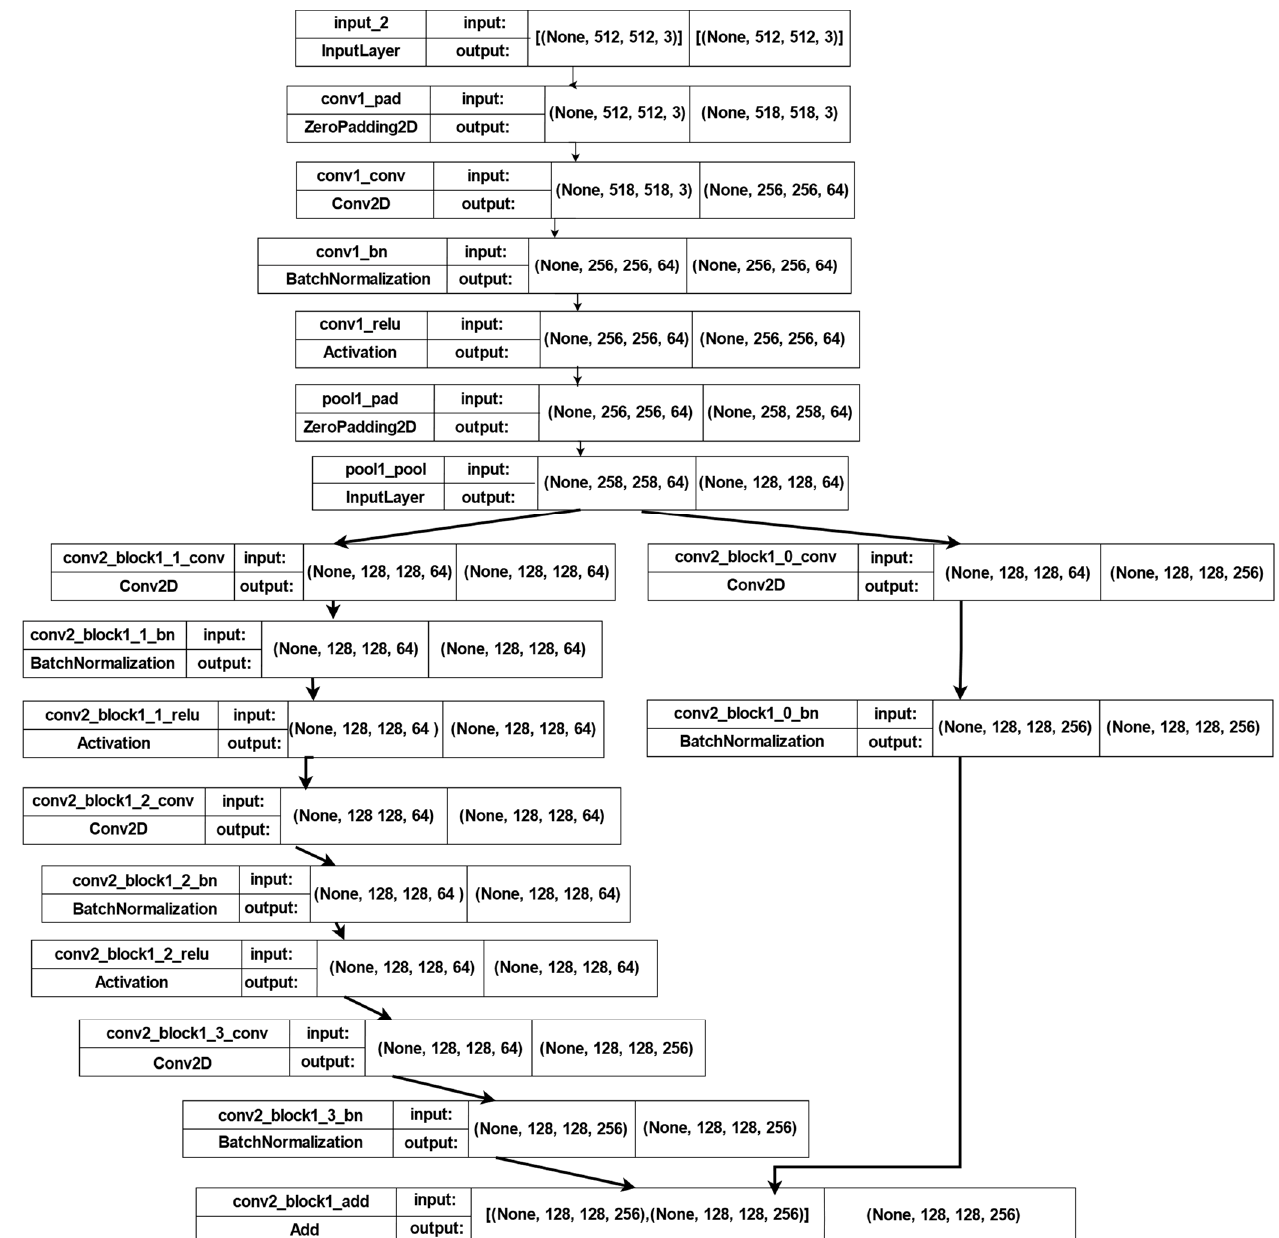
Figure 3. The first part of the architecture of the first model.